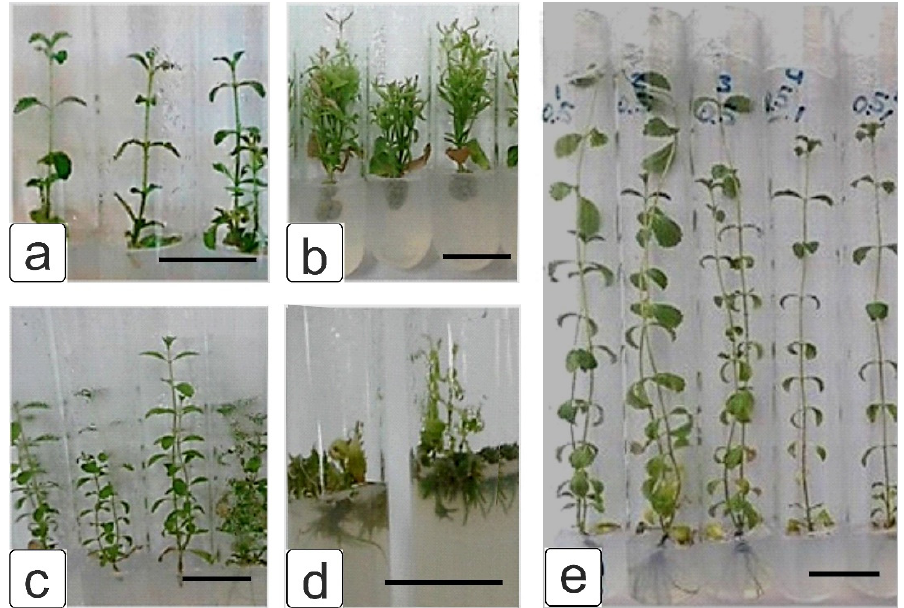
Figure 4. Morphological differences of S. rebaudiana microshoots cultured in vitro on various media. Figured depict results of enculturation on: ( a ) PGRs-free MS media and on MS media supplemented with different PGRs; ( b ) 1 mg L − 1 kinetin and 0.5 mgL − 1 IAA; ( c ) 1 mg L − 1 BAP and 0.5 mg L − 1 IAA;